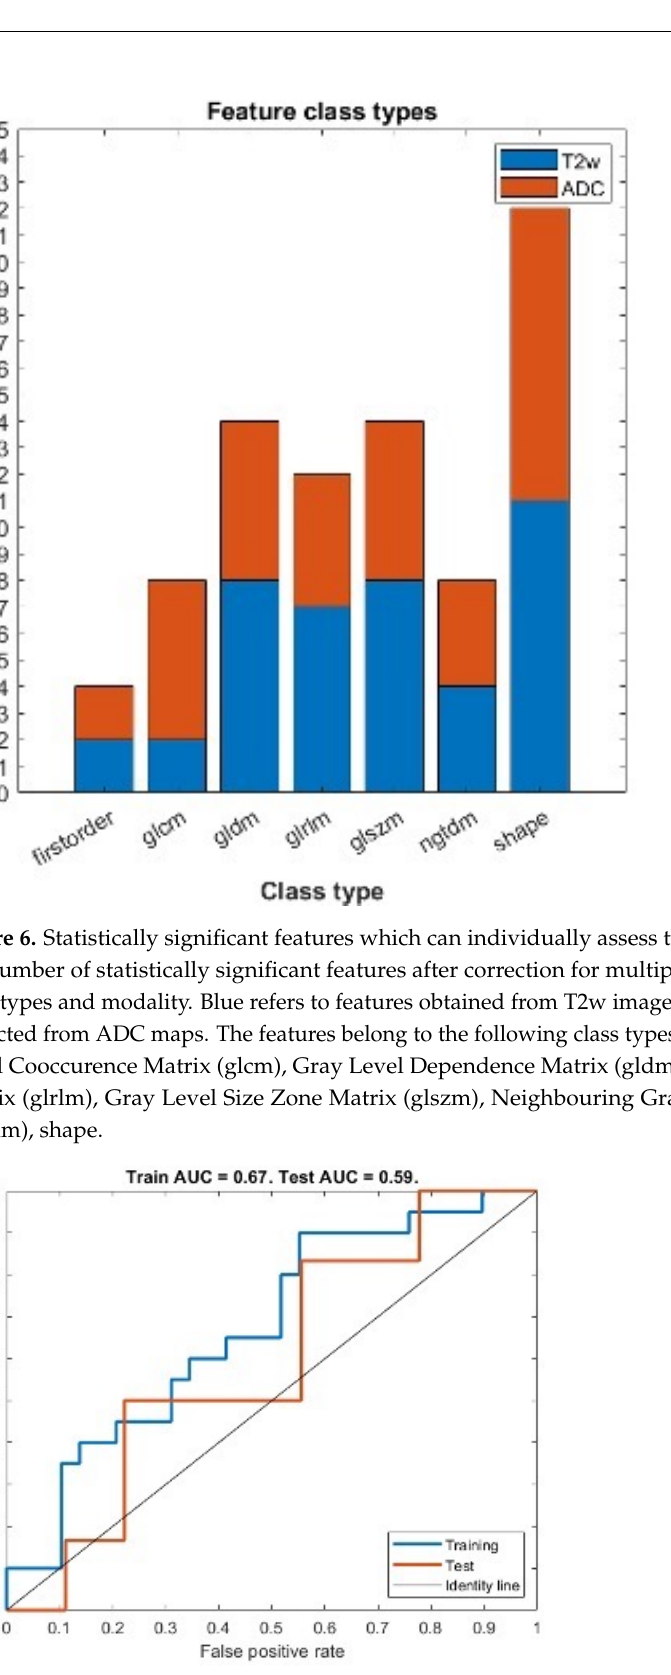
Figure 7. ROC curve for both training and test set of the best performing model for LVSI assessment.